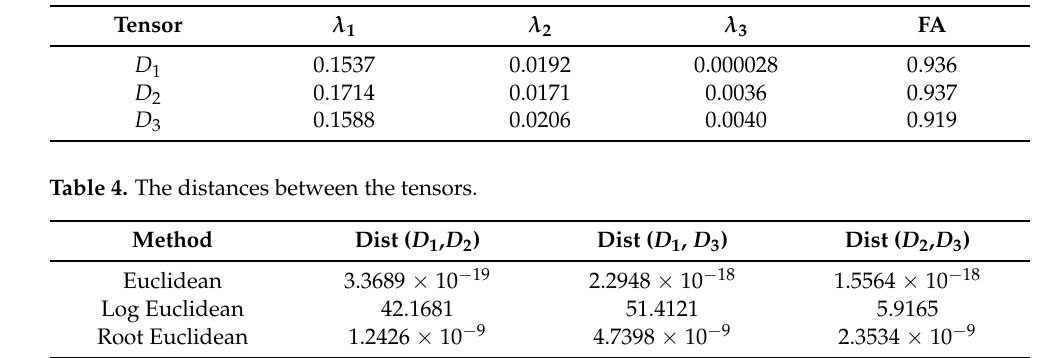
Table 3. Eigenvalues of D 1 , D 2 , and D 3 ( × 10 − 8 ) .